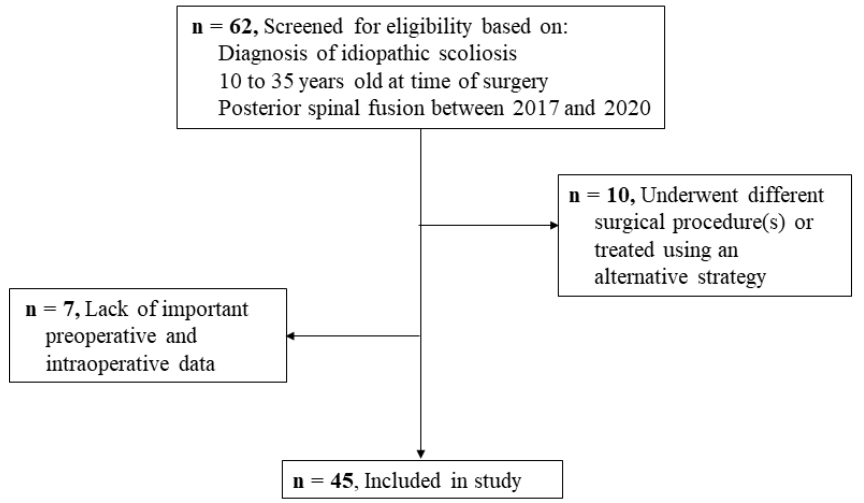
Figure 1. The flowchart of patient selection in this study. A total of 45 patients were finally included in this study.